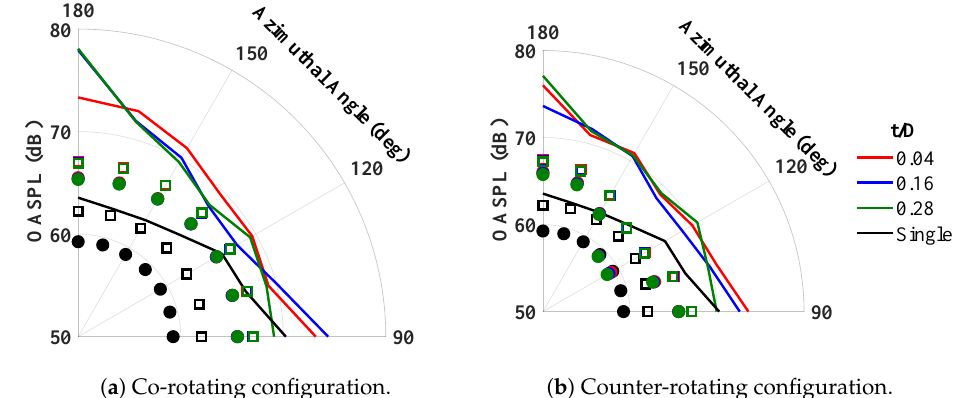
Figure 20. Overall sound pressure level of the dual rotors in hover at 6000 RPM versus azimuthal angle. Experimental results are shown as lines. Total noise from Helios/PSU-WOPWOP combined with UCD-Quietfly is shown as squares. Standalone Helios/PSU-WOPWOP predictions are shown as